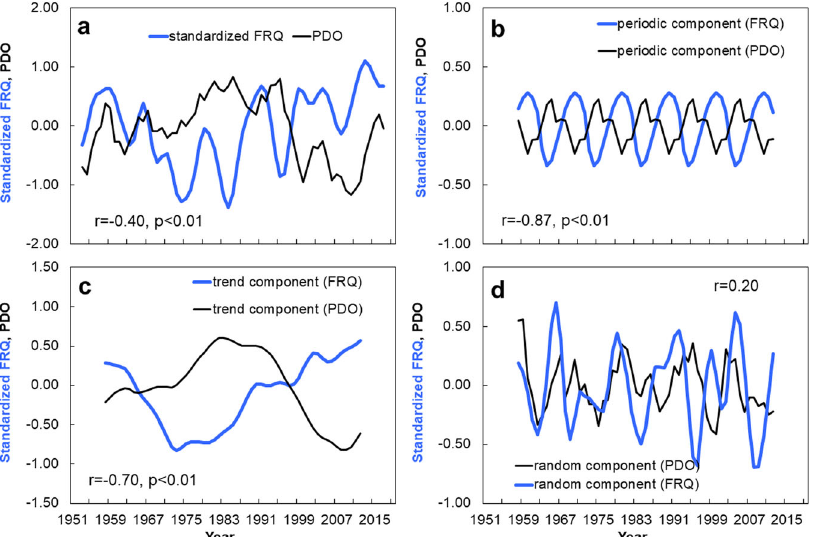
Fig. 8 Temporal decomposition of the extended tropical cyclone (TC) passage frequency during the mature boreal autumn from 1951 − 2019. a The blue and black line represents the timeseries of the standardized TC passage frequency (FRQ) and the Paci fi c Decadal Oscillation (PDO), respectively. b − d Same with a but shows the periodic, trend, and random components of the standardized FRQ and PDO, respectively. In a − d , the inset correlation coef fi cients show the correlation of the raw and decomposed standardized FRQ components and PDO. Signi fi cance is tested using student ’ s t-test statistic with two-tailed